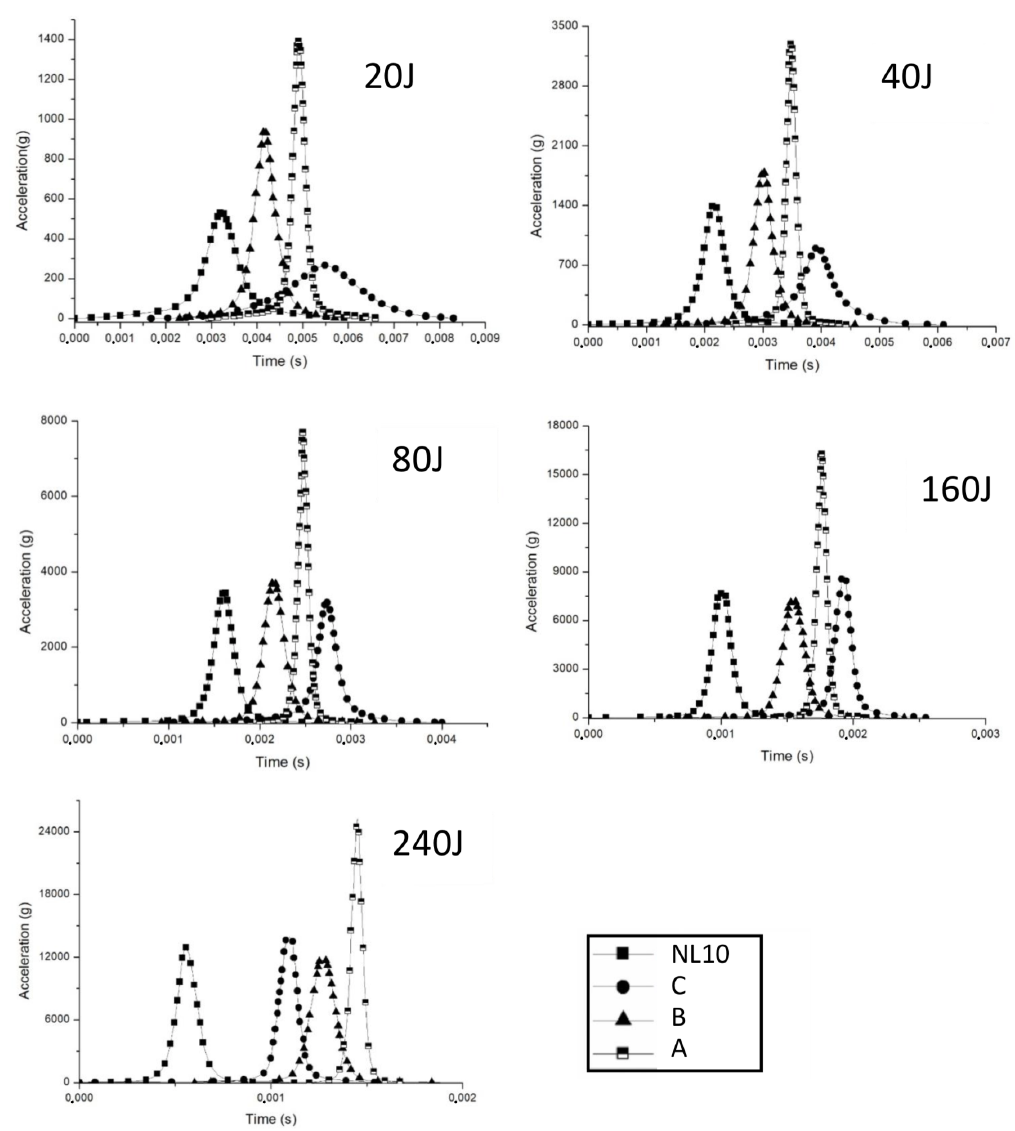
Figure 9. Headform impact test result for the studied headbands.